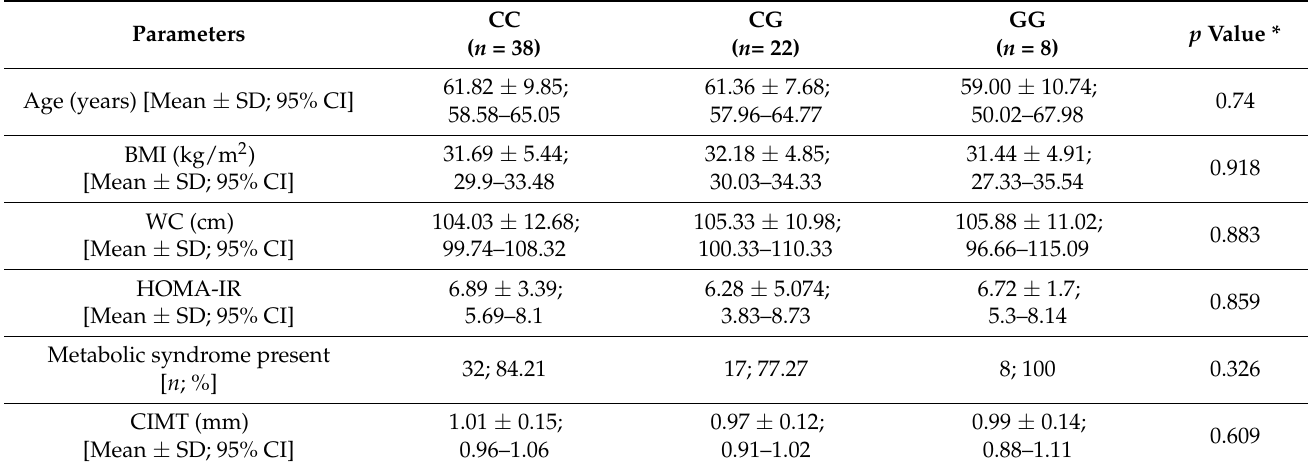
Table 7. Characteristics of the study subpopulation in relation to the genotype